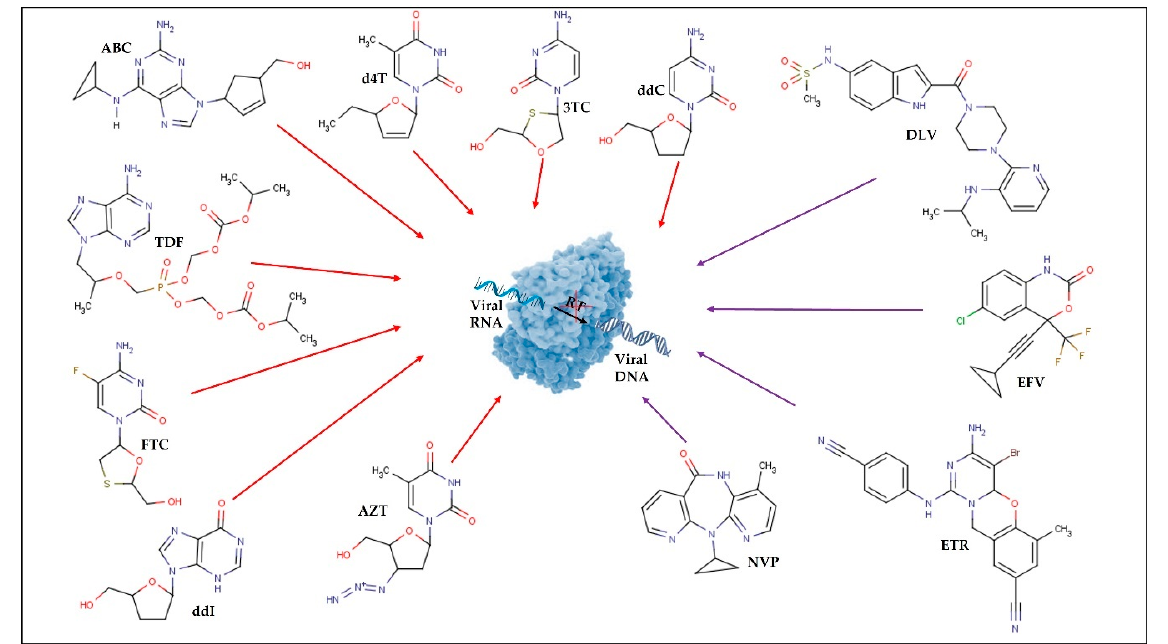
Figure 4. Reverse transcriptase (RT) inhibitors. Red arrows represent the nucleoside reverse transcriptase inhibitors (NRTI): lamivudine (3TC); abacavir (ABC); zidovudine (AZT); stavudine (d4T); didanosine (ddI); zalcitabine (ddC); emtricitabine (FTC); tenofovir disoproxil fumarate (TDF). Purple arrows represent the non-nucleoside reverse transcriptase inhibitors (NNRTI): efavirenz (EFV); etravirine (ETR); nevirapine (NVP); delavirdine (DLV).